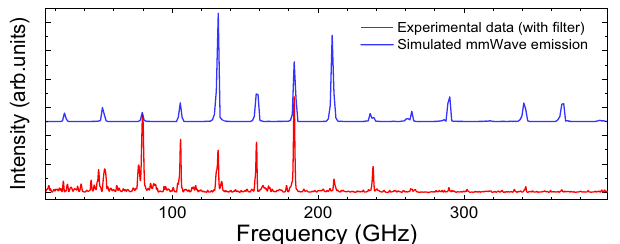
Fig. 2 Enhanced view of mmWave spectral emission from QCL 1 (red) showing comparison with simulated results (blue) from the QCL THz spectrum. mmWave emission is observed up to 367 GHz.